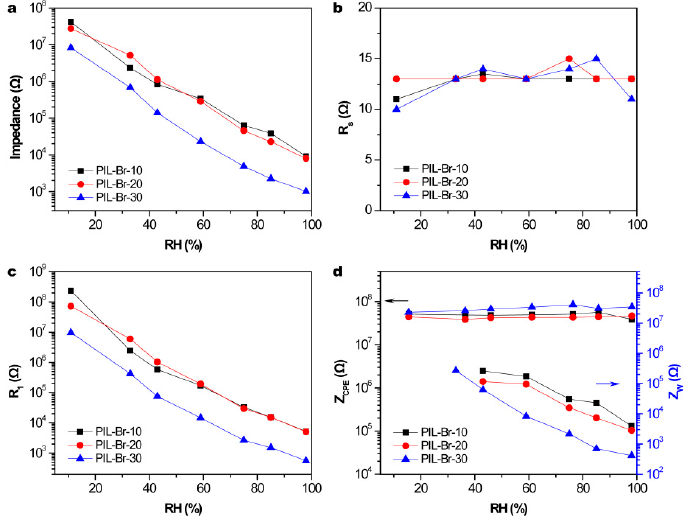
Figure 7. Dependence of the values of ( a ) total, ( b ) Rs , ( c ) R 1 and ( d ) Z CPE and Z W on varying RH levels for PIL-Br sensors with different